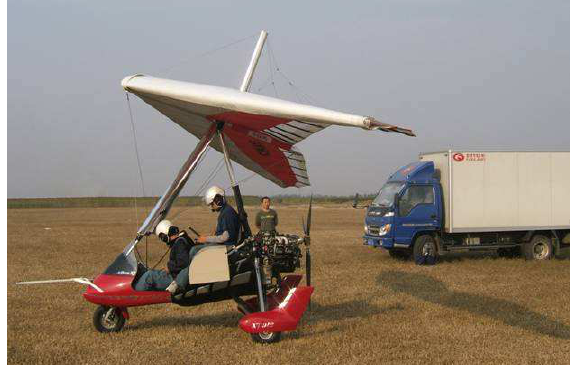
Figure 4: Trike of the Bureau for Surveying and Mapping of the Province Hebei / China